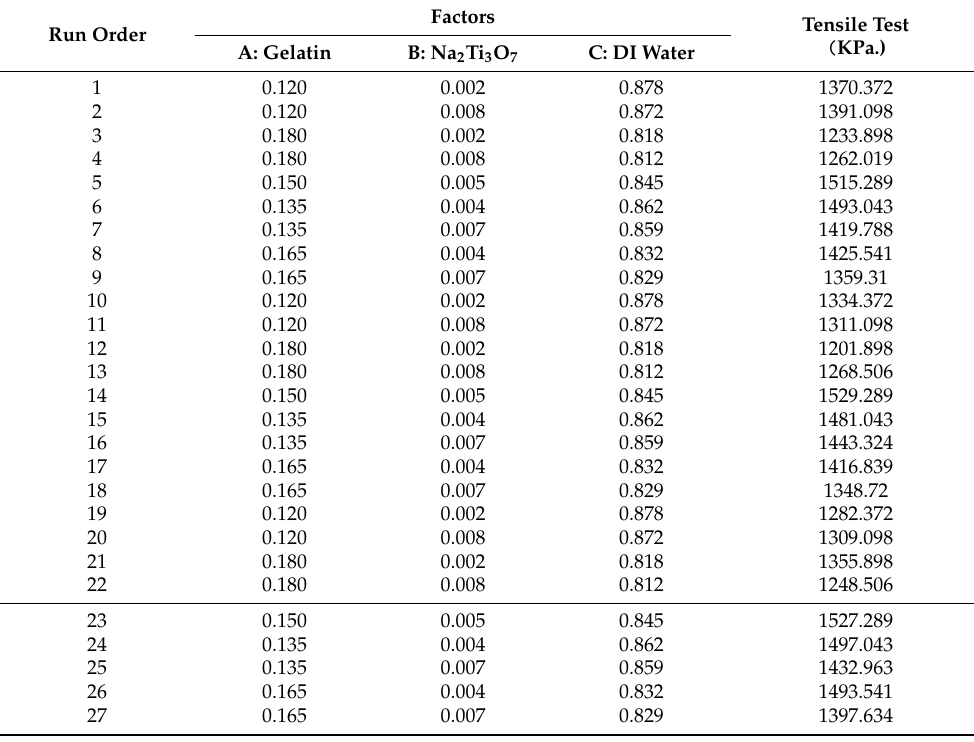
Table 2. Experimental design and